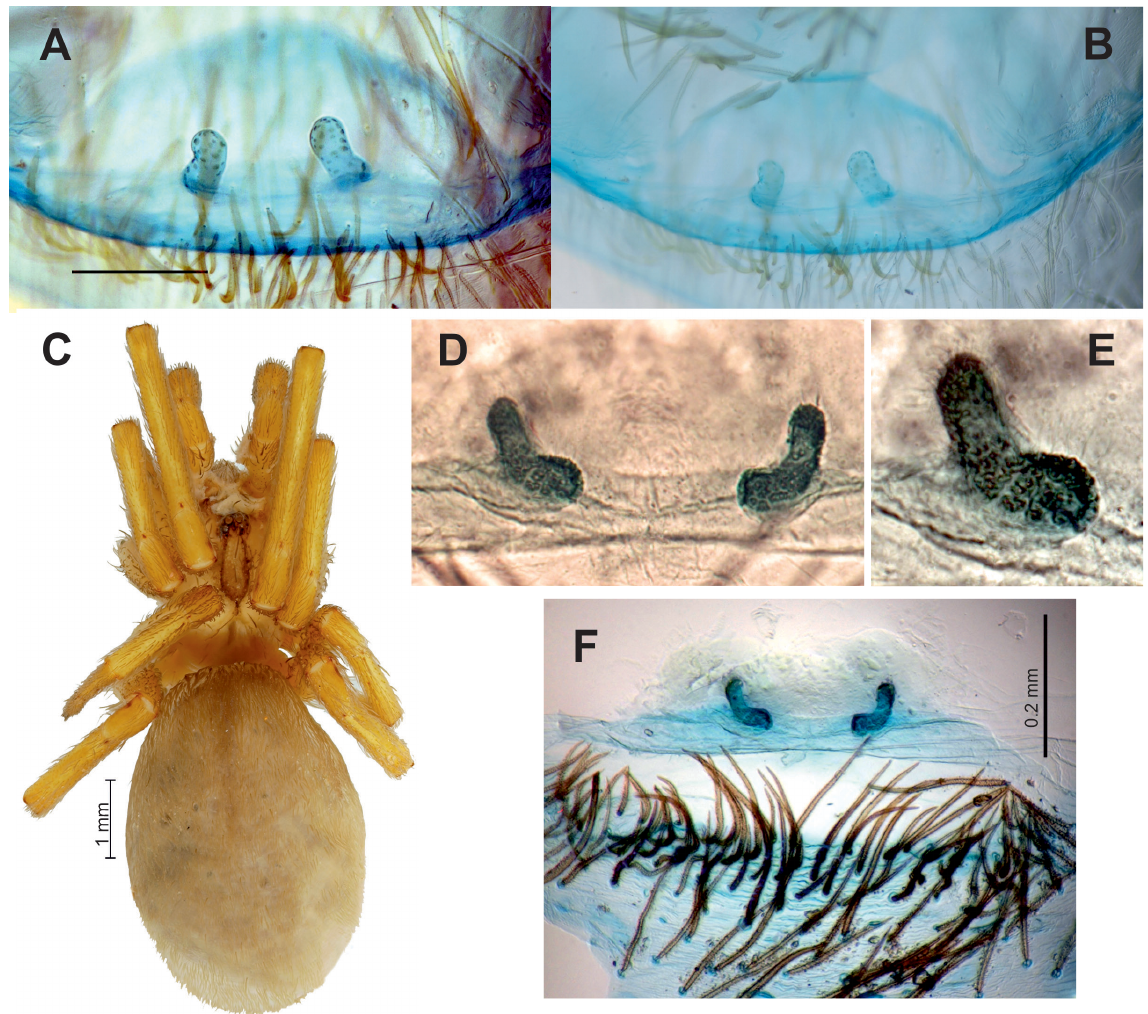
Fig. 16. Zaitunia alexandri Brignoli, 1982 ( A–B ) and Z. brignoliana sp. nov. ( C – F ), holotype; ♀♀, habitus and structure of endogyne. — A–B , D , F . endogyne, dorsal. C . Habitus, dorsal. E . Left receptacle, dorsal. Scale bars: a, F = 0.2 mm; C = 1.0